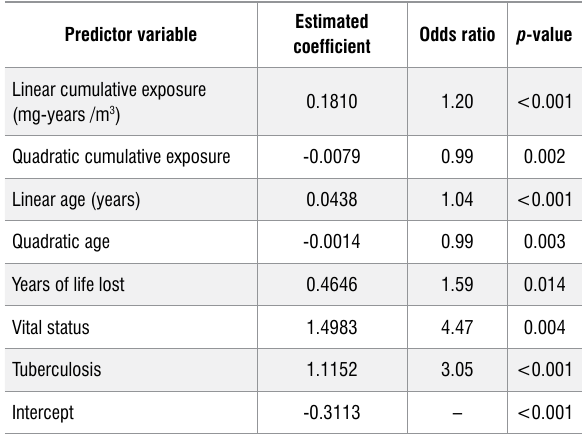
Prediction group ( n =466)